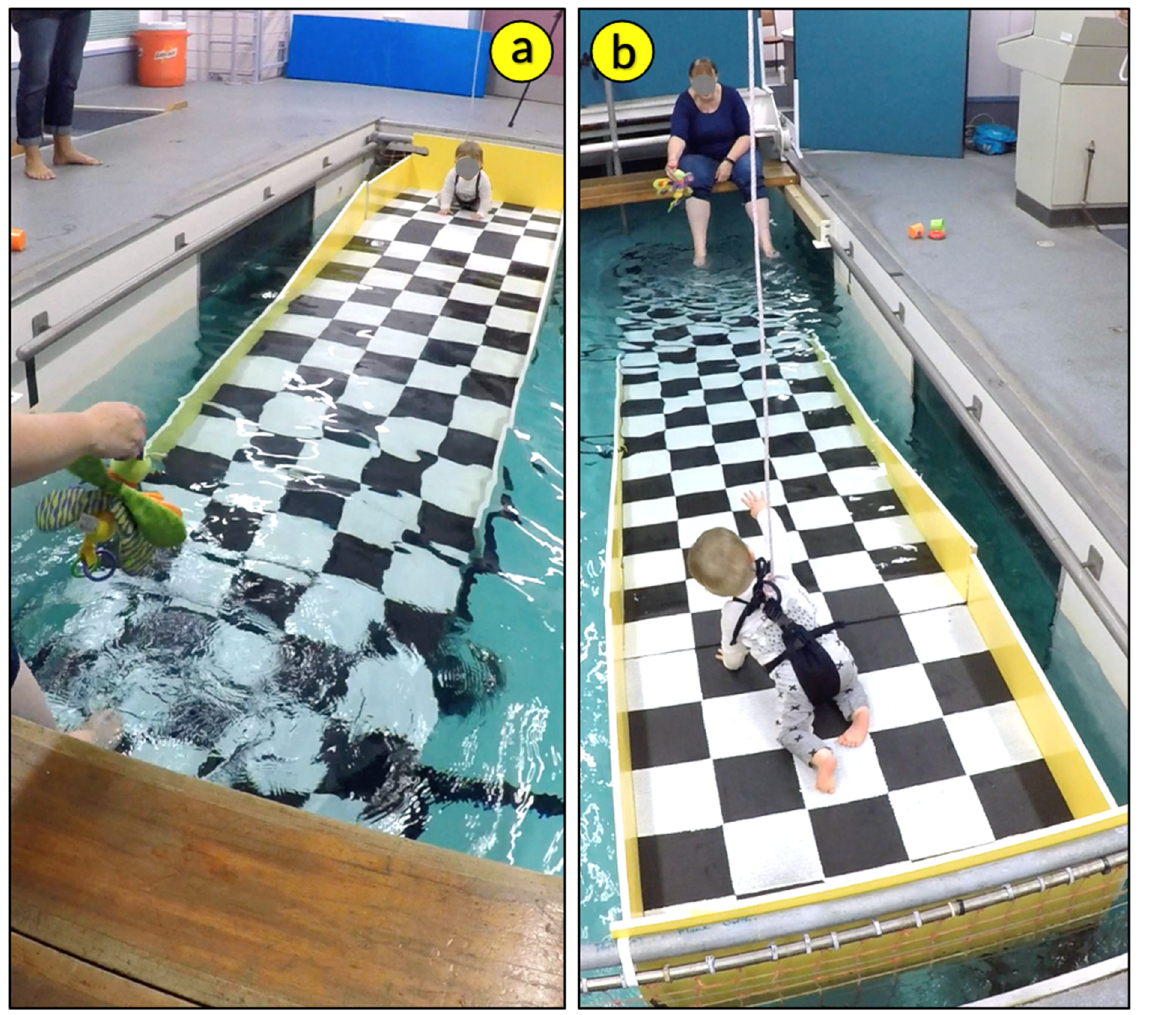
Figure 2. Water slope apparatus synchronized cameras’ view. ( a ) camera front view and ( b ) camera back view. Photo reproduced with permission of the infant’s mother.